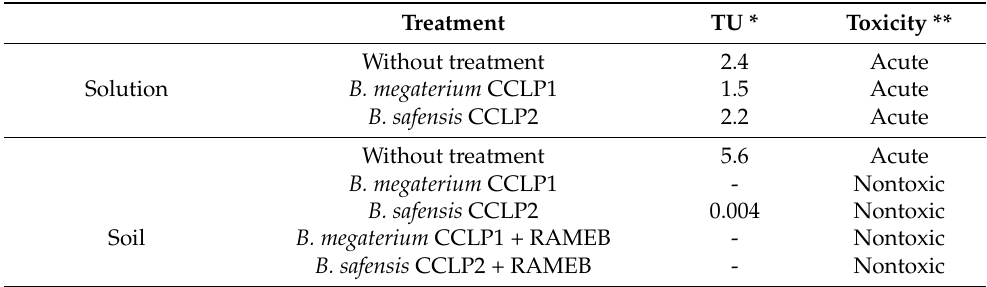
Table 6. Acute toxicity test towards V. fischeri after the testing time (after 60 d of incubation in solution, and after 100 d in ALC soil contaminated with chlorpyrifos) in the presence of B. megaterium CCLP1, B. safensis CCLP2, and/or RAMEB. Treatment TU * Toxicity ** Without treatment 2.4